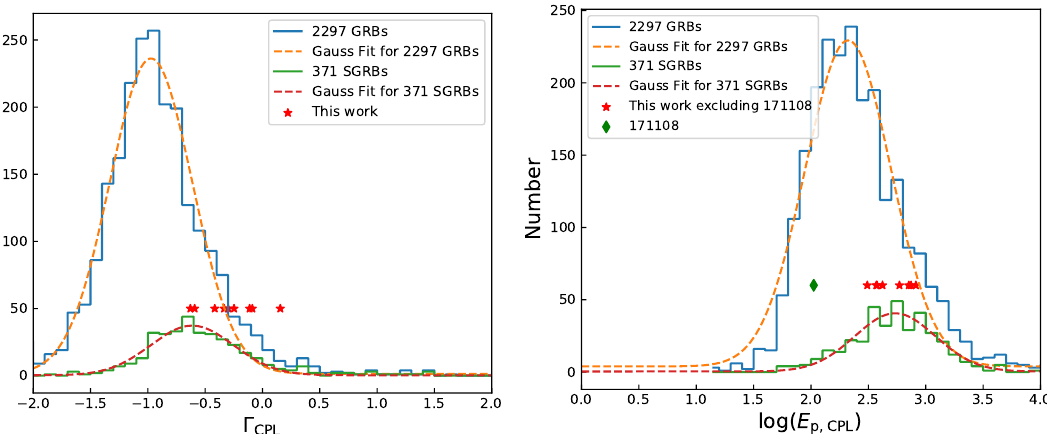
Figure 2. Comparisions of the CPL spectral parameters between three samples: the catalog sample, the SGRB sample and the sample in this work. ( Left ) Γ cata = − 0.97 ± 0.72, Γ SGRB = − 0.61 ± 0.72. ( Right ) E peak, cata = 10 2.32 ± 0.75 keV, E peak, SGRB = 10 2.73 ± 0.70